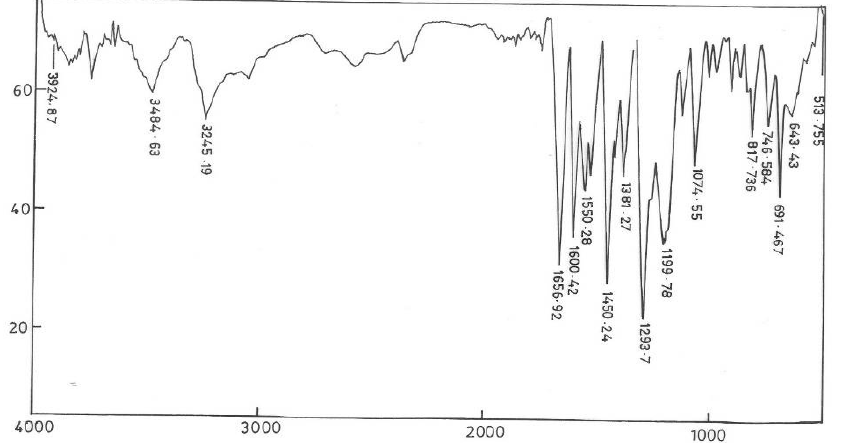
Figure 1 IR spectrum of 3, 4-Dihydroxybenzaldehyde isonicotinoyl hydrazone. Preparation of a stock solution of